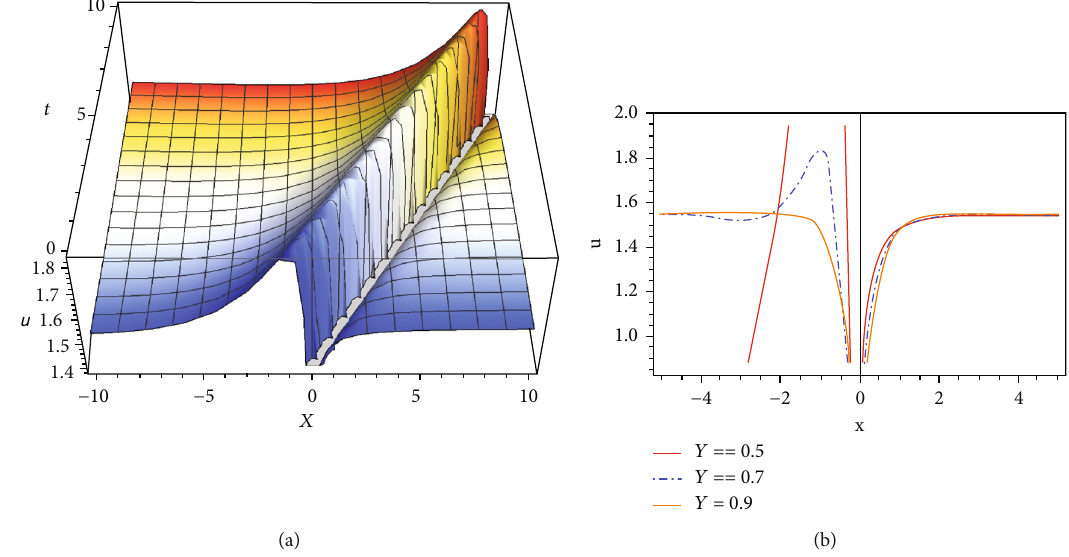
= 1 , T = 2 , V = 1 , c = 3 , a = 1 , b = 1 , and γ = 0 : 5,0 : 7,0 : 9 . for the solution j u 1